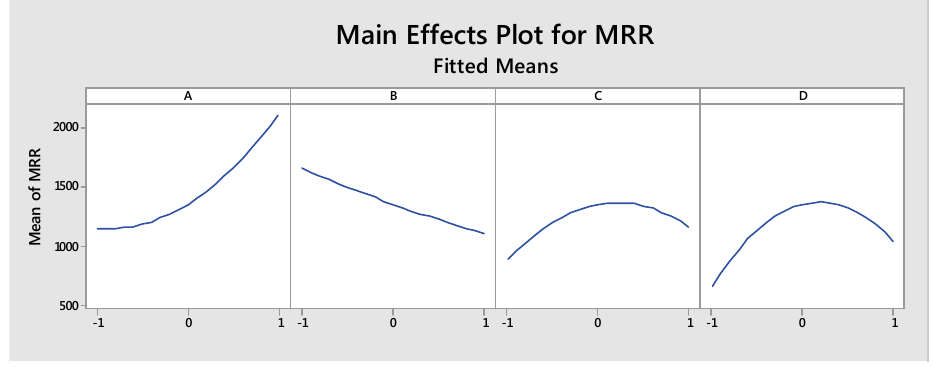
Fig. 7. Main effects plot for MRR